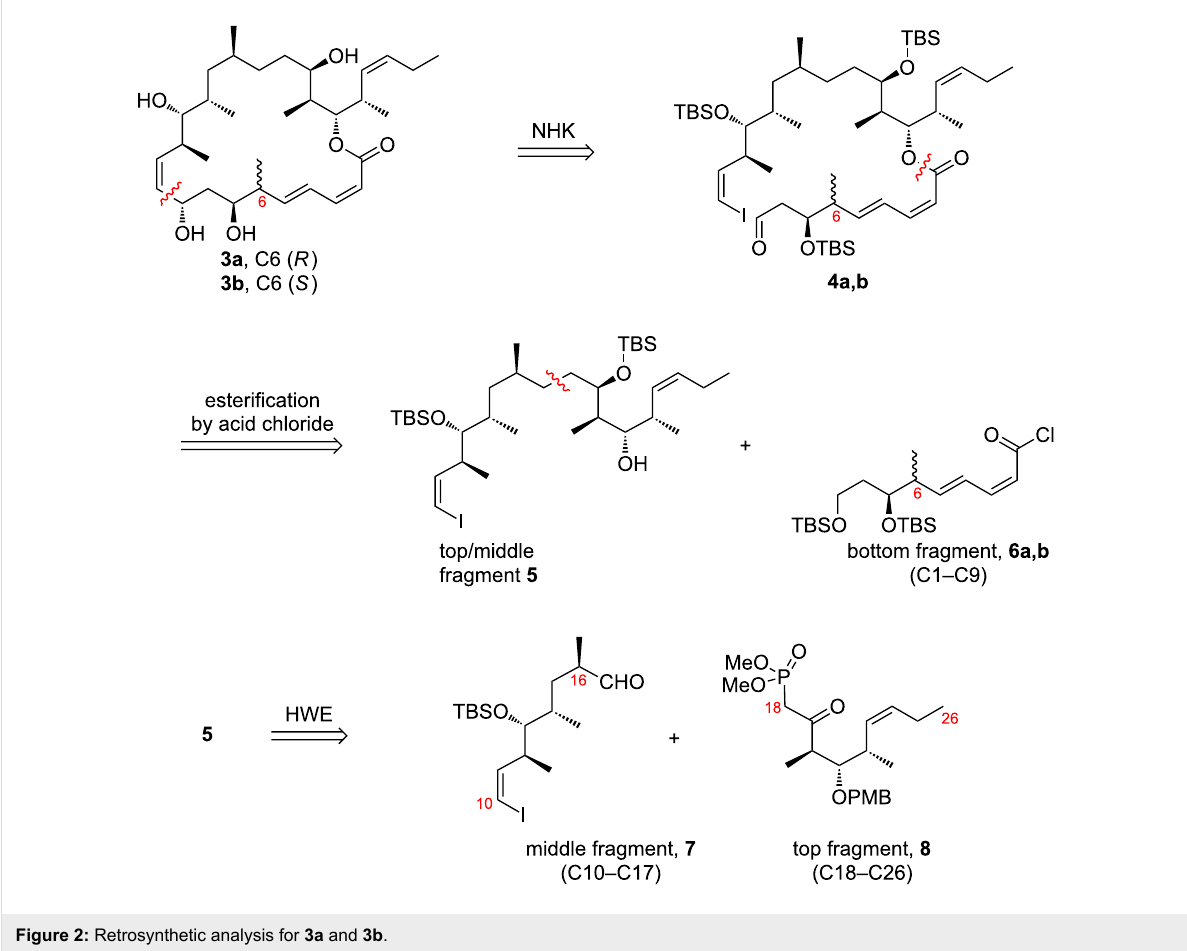
Figure 2: Retrosynthetic analysis for 3a and 3b